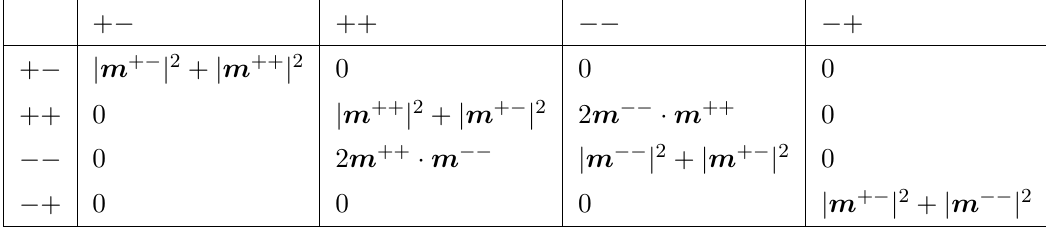
Table 2 . Sum rule for